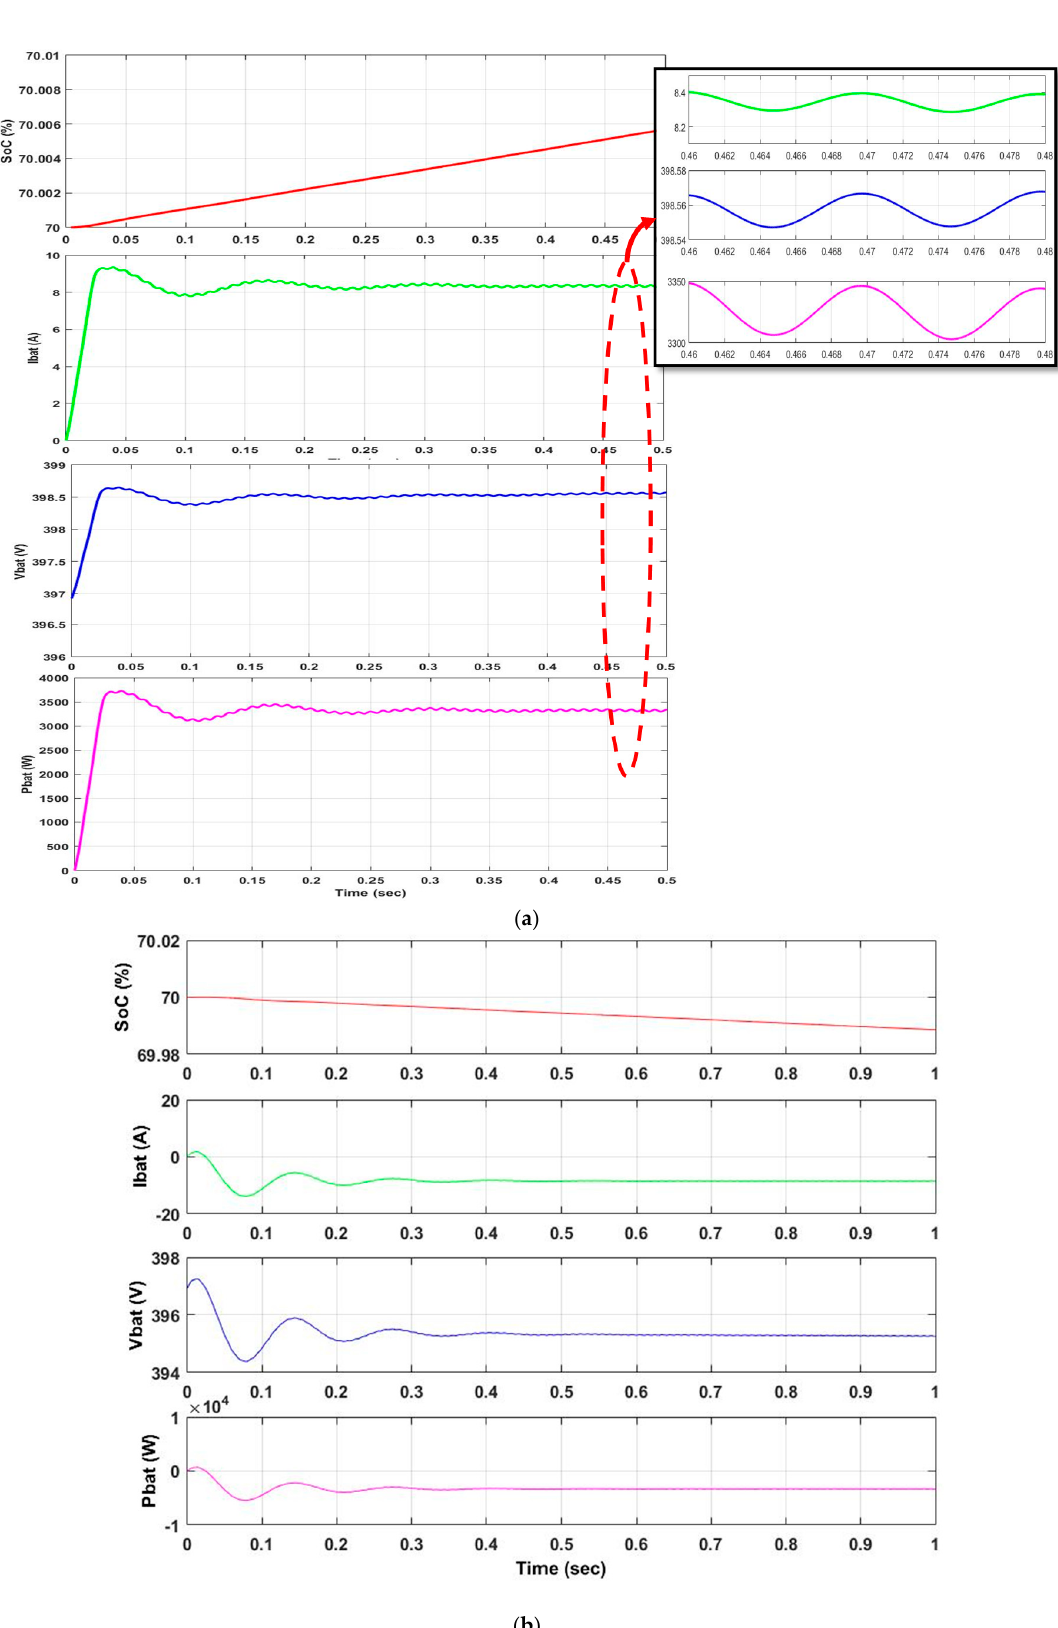
Figure 21. Battery Curves in G2V and V2G systems. ( a ) Charging: G2V; ( b ) Discharging: V2G.